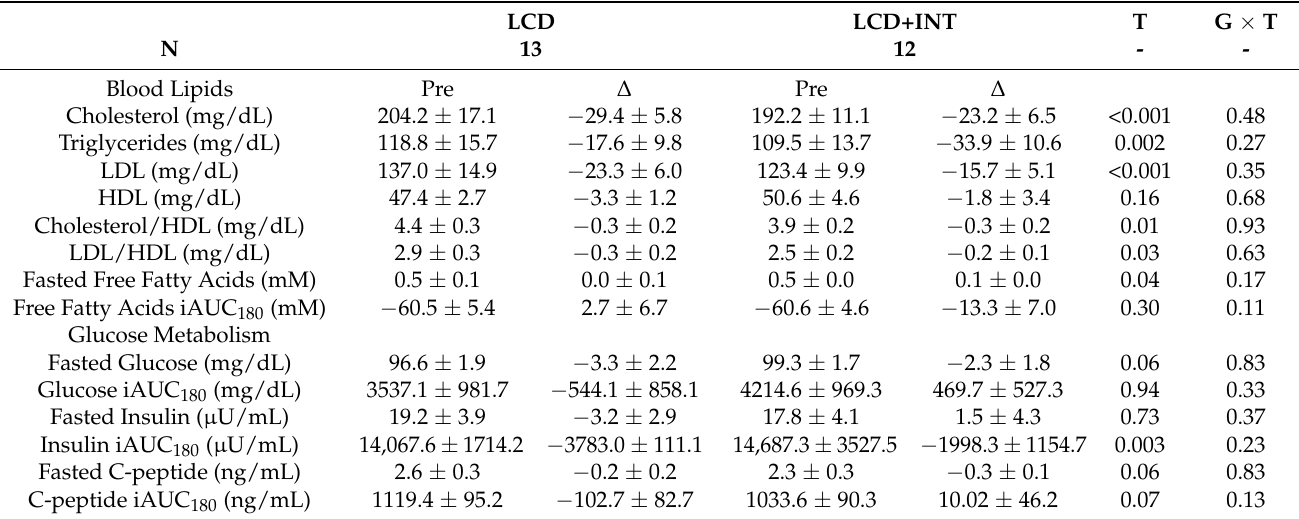
Table 2. Blood Lipids and Glucose Metabolism.